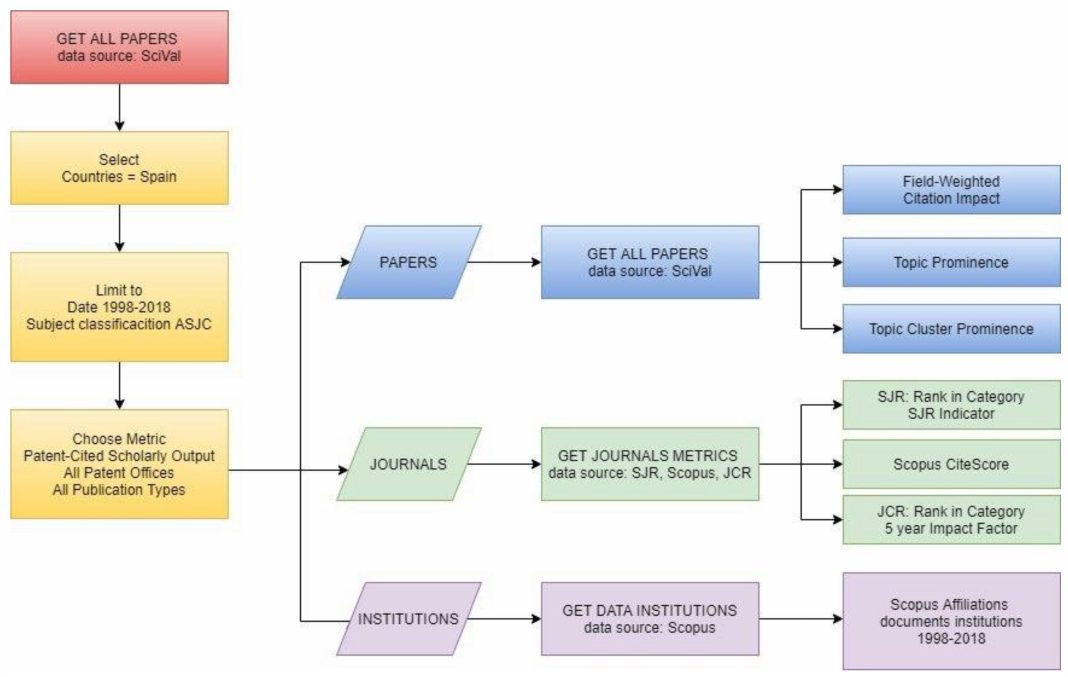
Figure 1. Methodology flowchart. Note: SJR (SCImago Journal Rank); JCR (Journal Citation